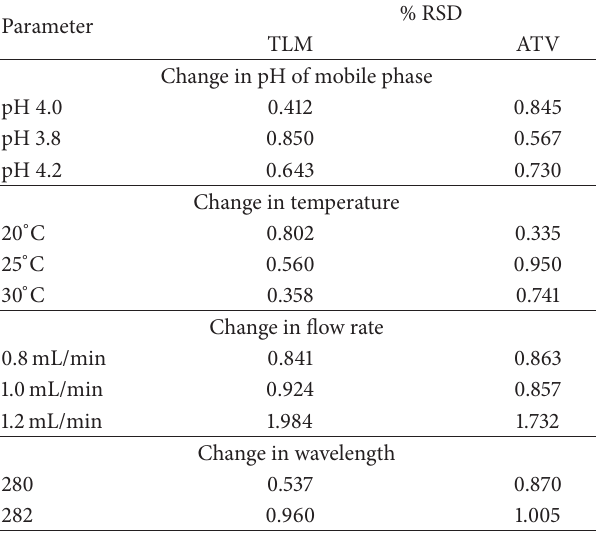
Table 3: Results of robustness study by HPLC.